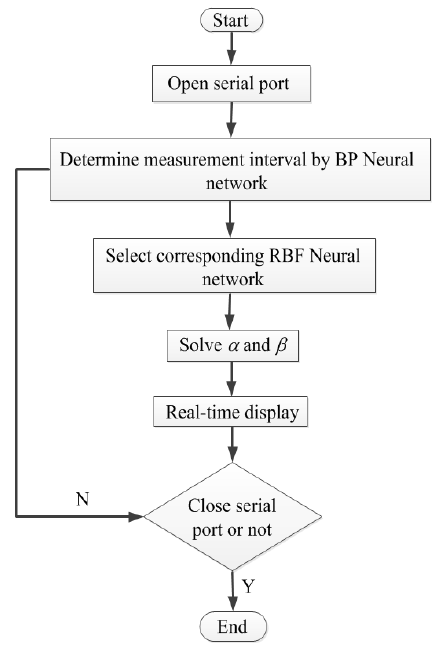
Figure 11. Flowchart of upper computer program.